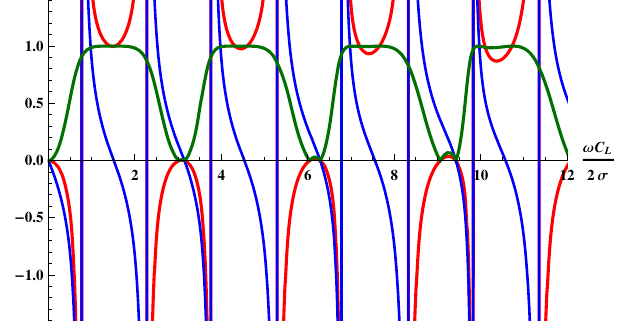
Þ − ð S Þ j = 2 , FIG. 10. Close-up of Fig. 9: jð S 2 2 P; λ 1 ; 2 2 ; 1 P; λ jð Y Þ j , and jð Y Þ j in green, blue, and red, respectively, 2 P; λ 2 P; λ 11 21 at low frequency. Over the first period of the response (i.e., for 0 < ω C = 2 σ < π ), the response shown here is almost indistin- FIG. 11. The construction of Carlin [2,56,57] for realizing a L guishable from that of the constant capacitance, Eqs. (25) and circulator of Fig. 1 and Eq. (1), given a nonreciprocal three- terminal device (terminals defined at solid dots) with admittance as in Eq. (32). Anticipating Sec. VI and Fig. 15, we depict the capacitive contacts as strips overlapping the edge of a rectangular piece of Hall material; the capacitances should be the same, and may or may not be rounded. Note that the primed terminals of each of the three external ports are tied together, but should be kept away from the Hall device so that they have no Ohmic or capacitive contact with it.